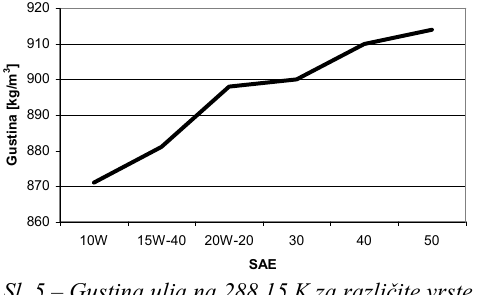
Sl. 8 – Prikaz baznosti u jednoj vrsti ulja razli č itog kvaliteta Toksi č nost ozna č ava sve aspekte